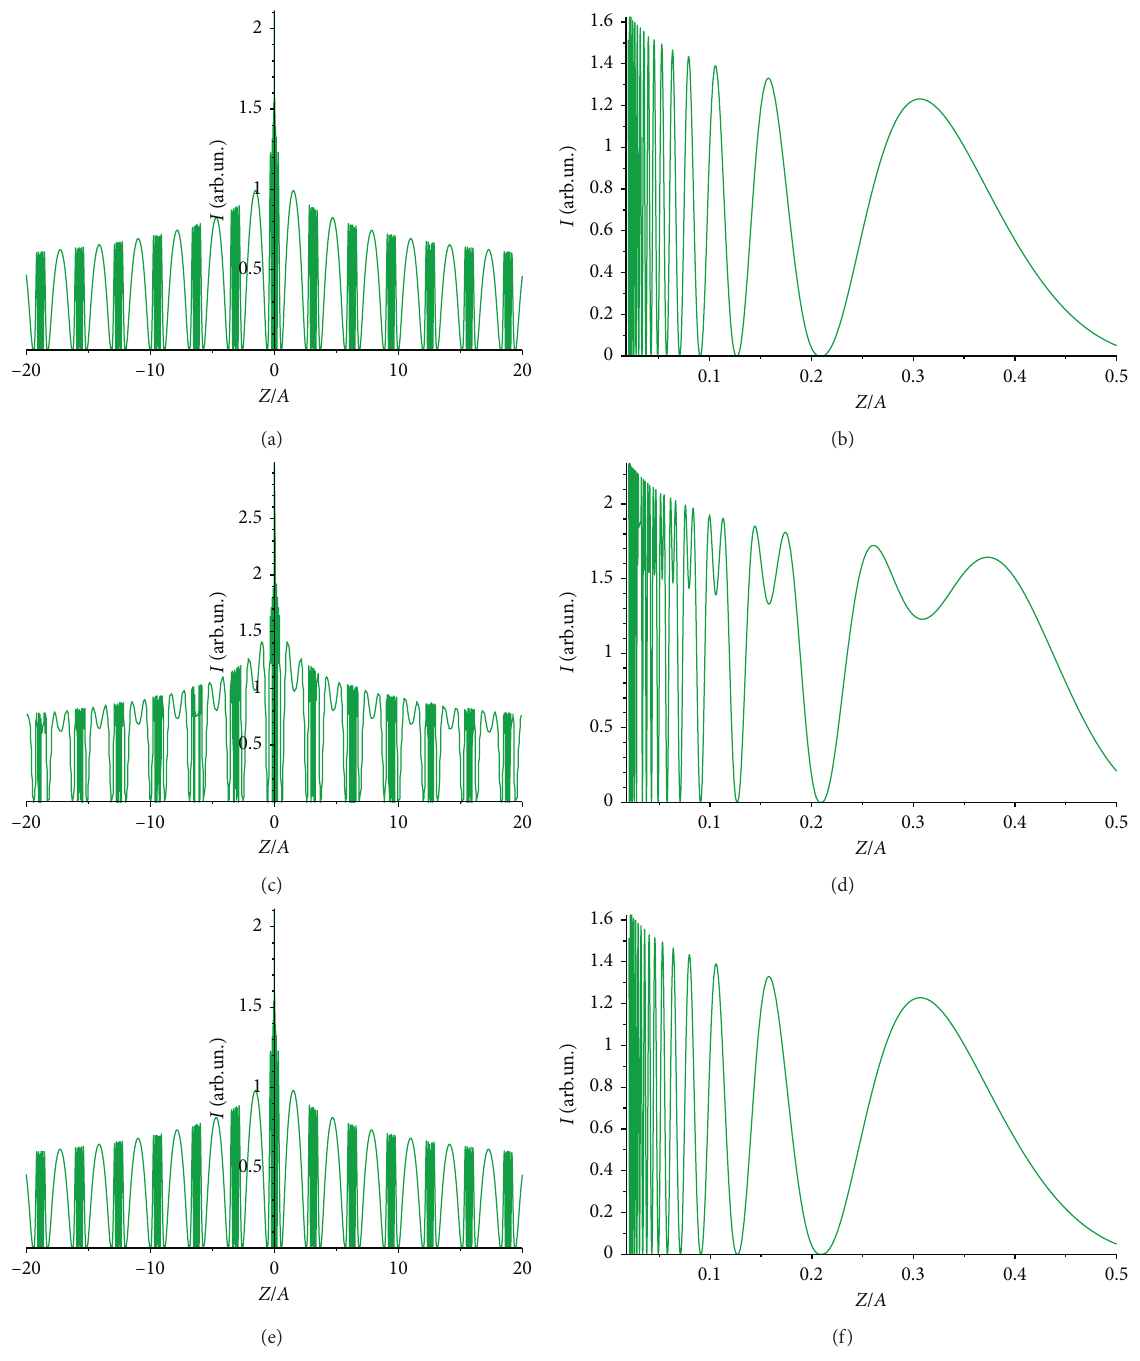
Figure 3: (a, b) Optical intensity resulting along the optical axis for Z � ( 655 × 10 − 3 ) m. (c, d) Optical intensity resulting in the geometrical focal plane for Z � ( 655 × 10 − 3 ) m. (e, f) Optical intensity resulting along the boundary of the geometrical shadow for Z � ( 655 × 10 − 3 )